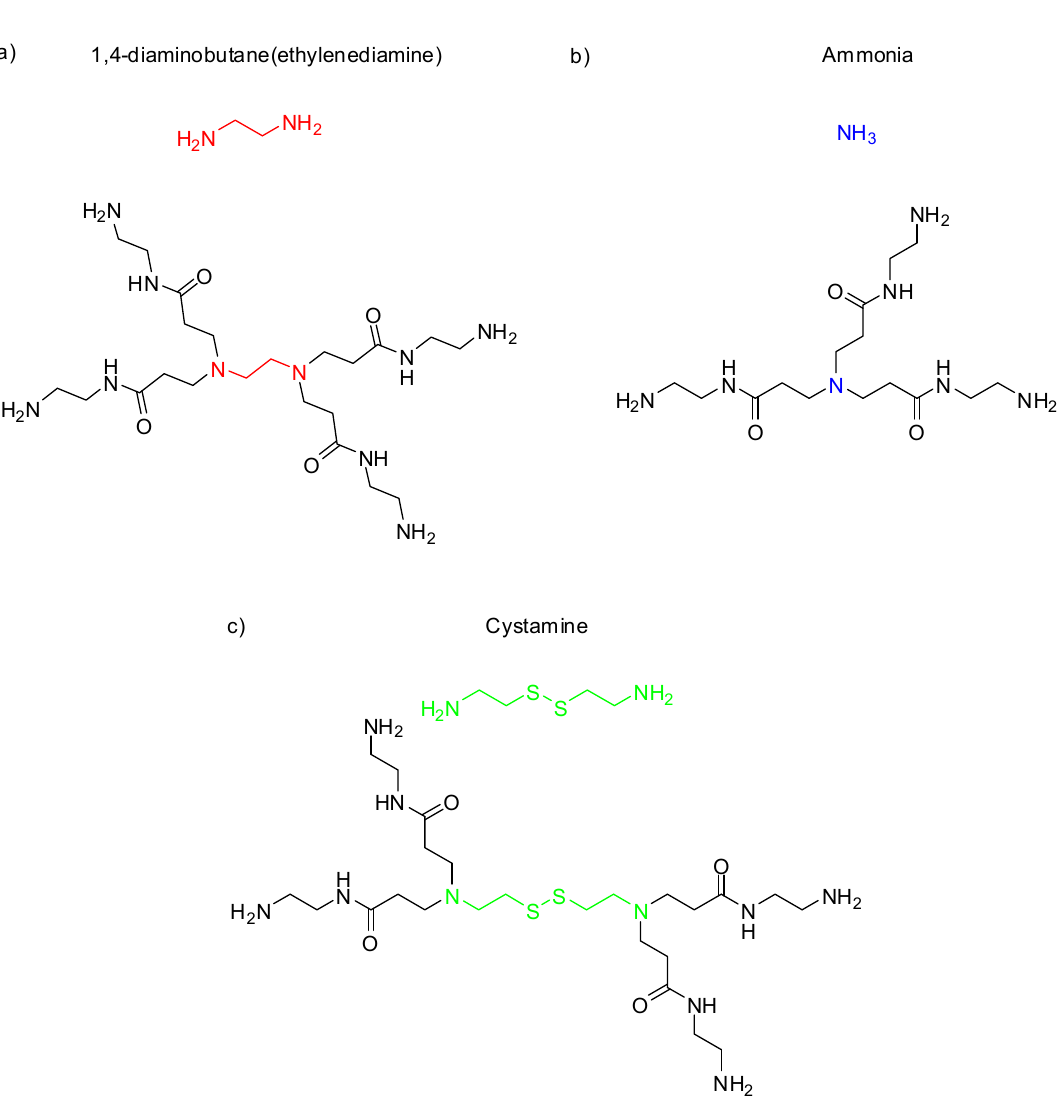
Figure 2. Common cores and G0 polyamidoamine (PAMAM) derivatives of each core.